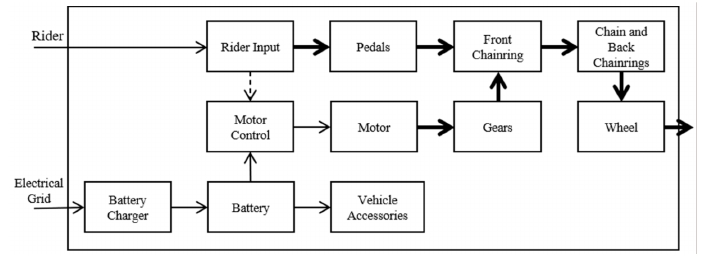
Figure 1. Block diagram for a mid-drive motor e-bike.